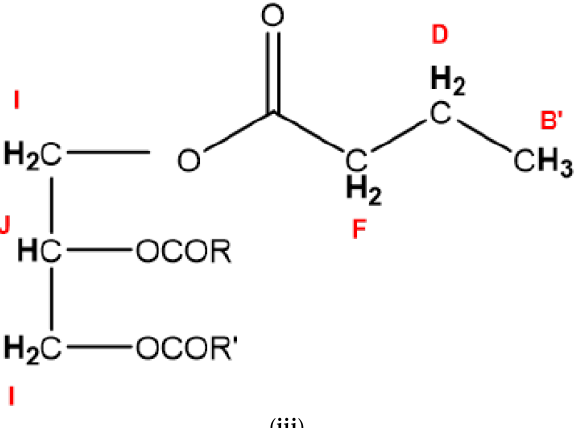
Figure 2. Two dimensional 1 H – 1 H ( i ) COSY and ( ii ) TOCSY spectra of resonances A, B’, C, D, E and F present within the 0.0 – 2.5 ppm regions of unheated ghee. Letter assignments of resonances correspond to those provided in Table 2. ( iii ) An open structure of butyric acid/ester acyl groups identified in the 1 H (Figure 1i,ii), as well as in the 1 H- 1 H COSY (Figure 2i) and TOCSY (Figure 2ii) NMR spectra of ghee. R and R’ denote any FA acyl groups esterified to the triacylglycerol backbone. Linked 1 H- 1 H resonances for the acyl fatty acid chains of SFAs, MUFAs and PUFAs are also clearly visible in these spectra.